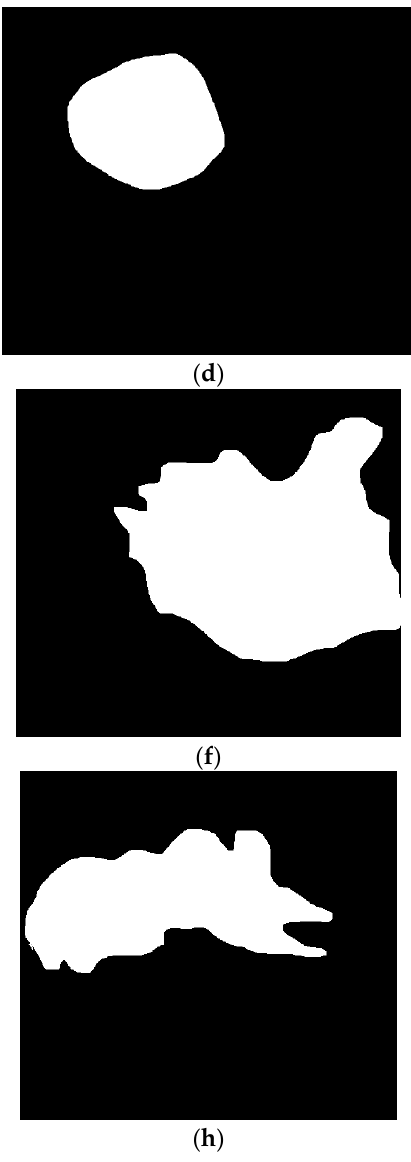
Figure 1. Samples of breast ultrasound images: ( a , c ) grayscale image of a benign lesion; ( b , d ) ground truth for benign lesion; ( e , g ) grayscale image of a malignant lesion; ( f , h ) ground truth for malignant lesion [32].